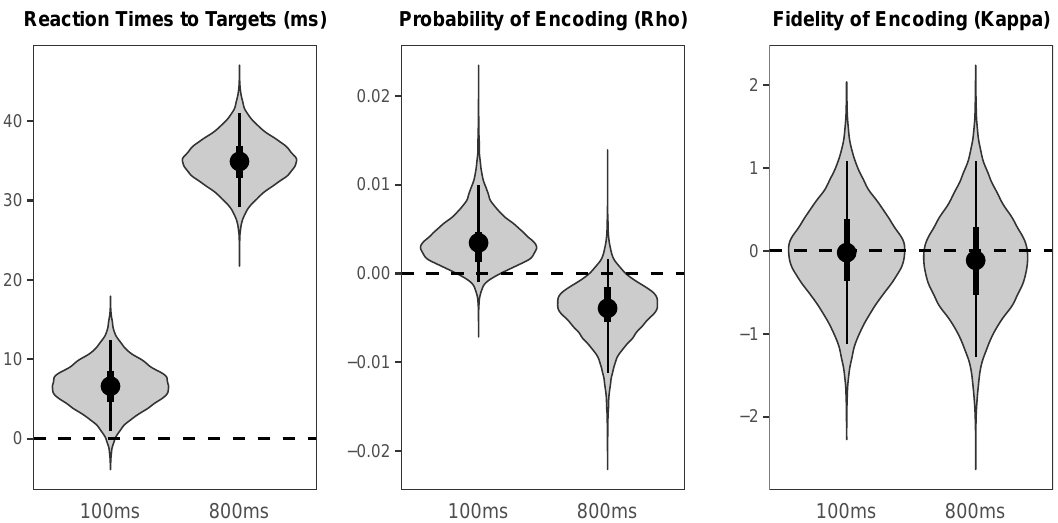
Figure 9. The probability distributions for the effects of cue validity (Valid minus Invalid) for each parameter of interest at the short (100 ms) and long (800 ms)